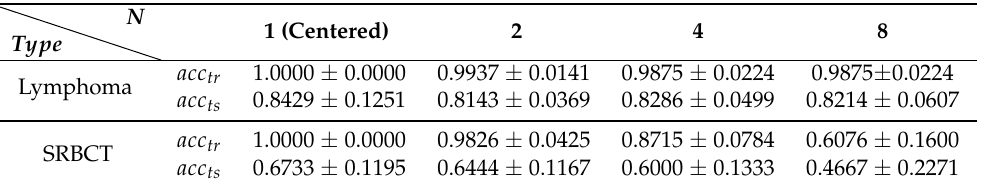
Table 4. Classification accuracy of Gene data: number of local servers ( N ), training and testing accuracy of Algorithm 3 ( acc tr , acc ts ).